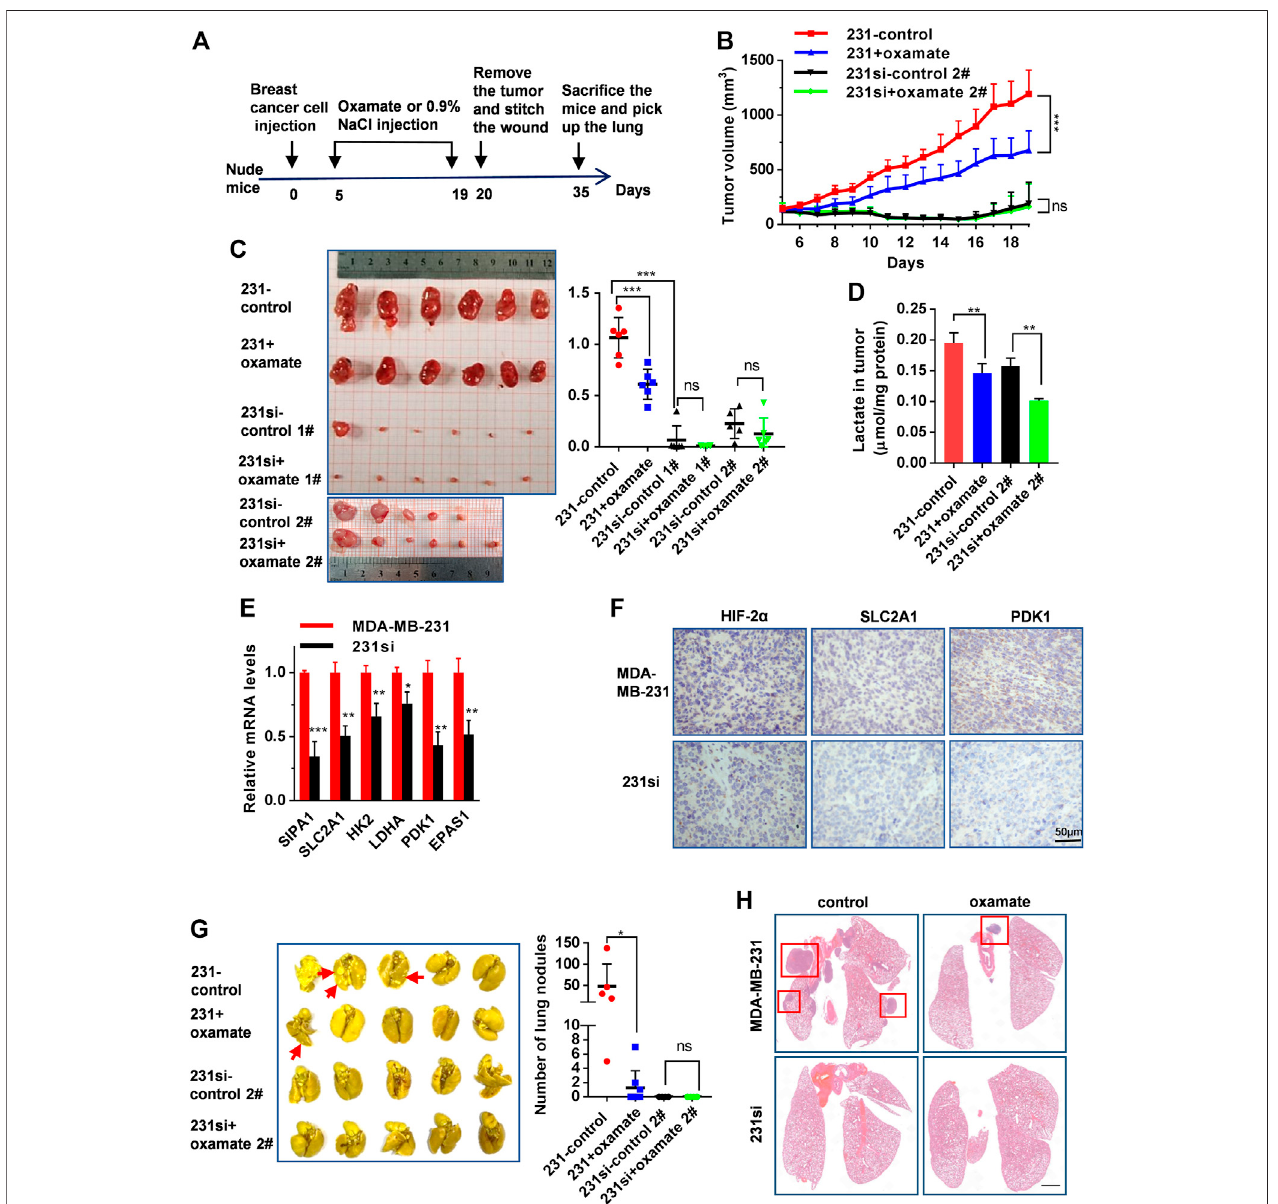
FIGURE 5 | SIPA1/HIF-2 α axis blockade suppresses aerobic glycolysis and breast cancer growth and metastasis in a xenograft mouse model. (A) The schematic overview of the xenograft experimental work fl ow. Oxamate treatment on 231si cell xenografted tumor formation experiment was done twice (1# and 2#). (B) Tumor volumes in the four groups of mice were measured from day 5 to day 19. (C) The tumors in each group were photographed and weighed. (D) Lactate levels in tumor tissues were determined in each group, n (cid:1) 3. (E) mRNA levels of glycolytic rate-limiting genes in tumor tissues of mice (n (cid:1) 3 in each group) were determined by qRT-PCR. Data are shown as mean ± s .d. The experiments were done in triplicate. (F) Immunohistochemical analyses of HIF-2 α , SLC2A1 and PDK1 in tumor tissues derived from two groups of mice were performed. (G) Lungs from four groups of mice were photographed (left panel) and the number of nodules observed on the lung surface were counted (right panel). (H) Representative histopathological images of HE staining in the lungs were presented. Scale bar: 1 mm. Data are mean ± s.d. of triplicate measurements. * p < 0.05, ** p < 0.01, *** p < 0.001. (Student ’ s t -test).